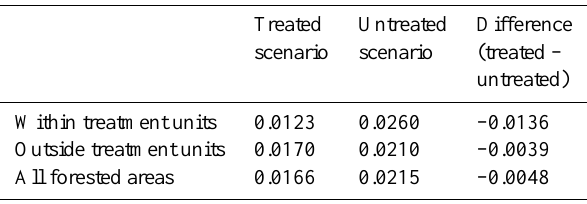
Table 2. Mean burn probabilities for the treated and untreated scenarios for the forested portion of the study area. Burn probability is the chance that a pixel burns given a random ignition in the study area and a resulting wildfire under the conditions described in the methods.